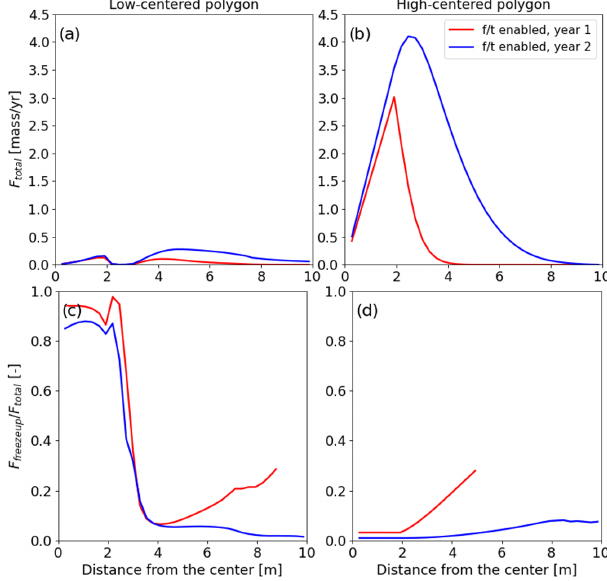
Figure 4. The low-porosity setup. The total flow rate ( F total ) repre- sents the tracer flow rates integrated over the vertical cross-section of the polygon and over the entire year at different distances from the center of the (a) low-centered and (b) high-centered polygon. The proportion of tracer flow rate during the freeze-up period rel- ative to the total flow rate at different distances from the center of the (c) low-centered and (d) high-centered polygon. F freezeup repre- sents the tracer flow rates integrated over the vertical cross-section of the polygon and over the freeze-up period at different distances from the